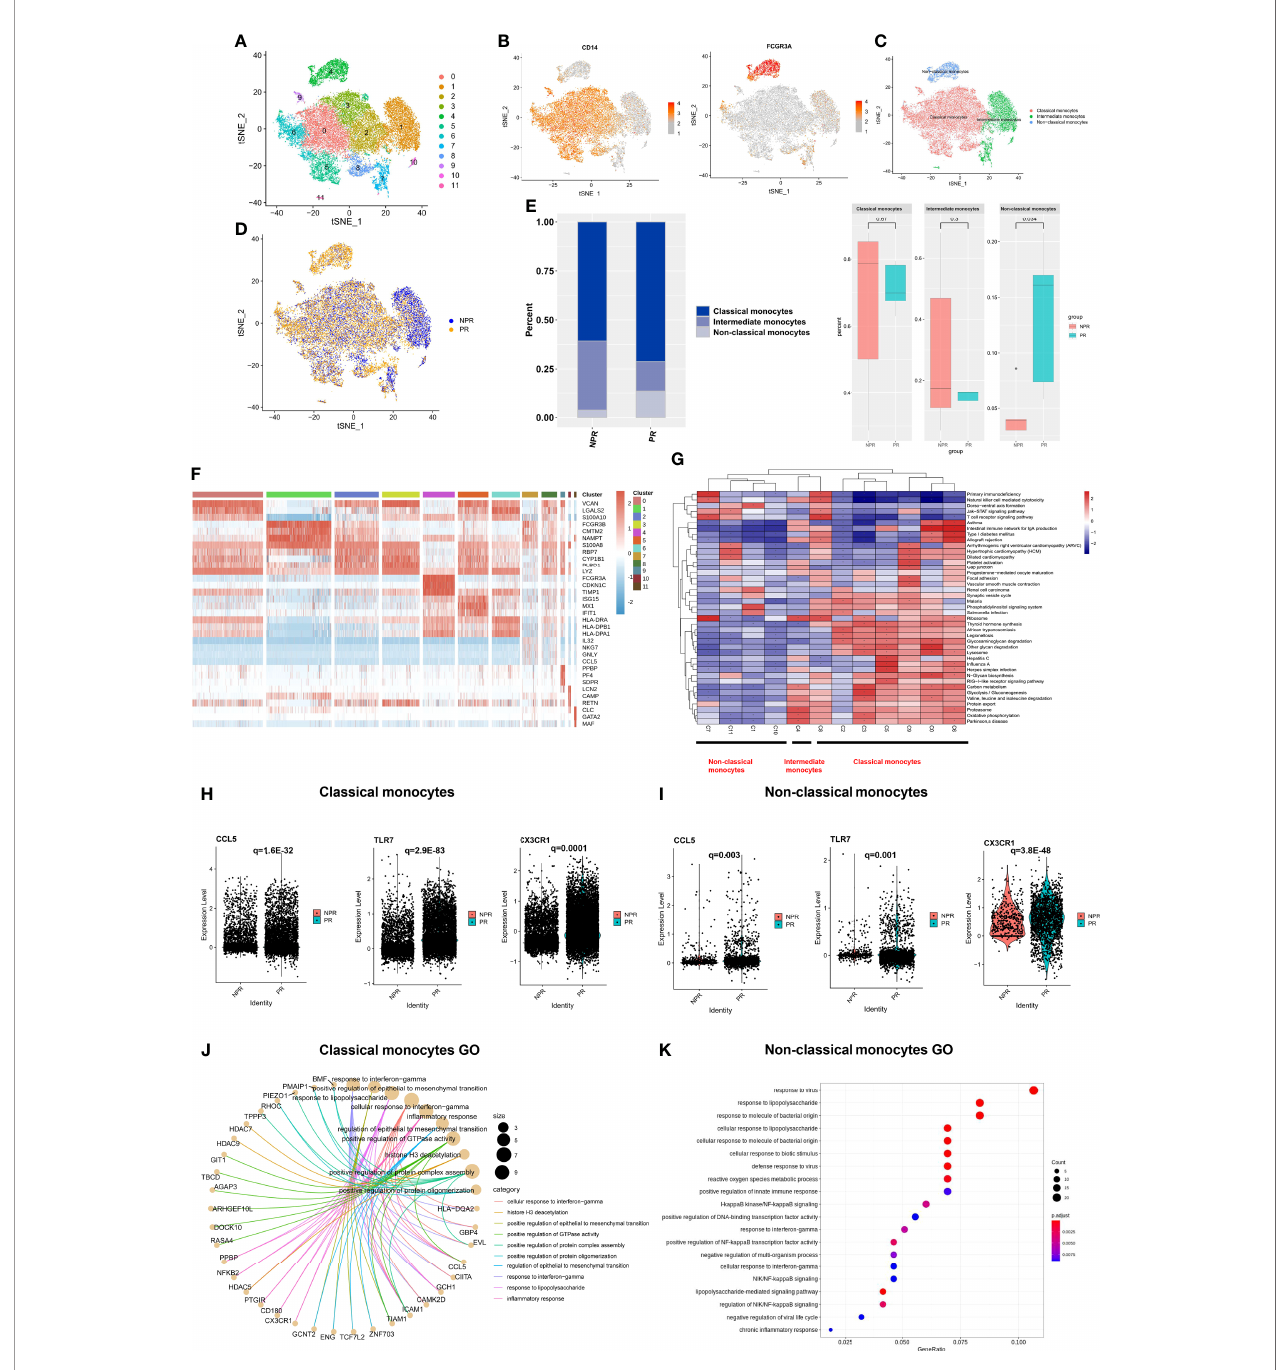
FIGURE 2 | Characterizations of circulating monocytes in patients with and without plaque rupture. (A) t-SNE plot showing re-clustering of monocyte cells into 12 clusters. (B) Expression t-SNE plot of monocytes markers CD14 and FCGR3A (CD16). (C) t-SNE plot of monocytes divided into three cell types: classical, intermediate, and non-classical monocytes. (D) t-SNE plot showing contribution of monocytes for patients with PR and NPR. (E) Percentage of monocytes subtype in patients with PR and NPR. (F) Heatmap showing expression levels of discriminative genes for each cluster. (G) GSEA heatmap of total cluster in monocytes. (H, I) Prototypical pro-in fl ammatory hub genes such as CCL5, TLR7, and CX3CR1 identi fi ed by STRING and Cytoscape were signi fi cantly upregulated in classical and non-classical monocytes derived from patients with PR. (J) Top GO terms of classical monocytes in patients with PR. (K) Top GO terms of non-classical monocytes in patients with